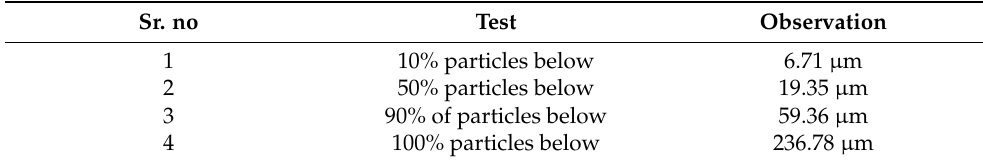
Table 4. Particle size analysis of encapsulated Dhavana oil.